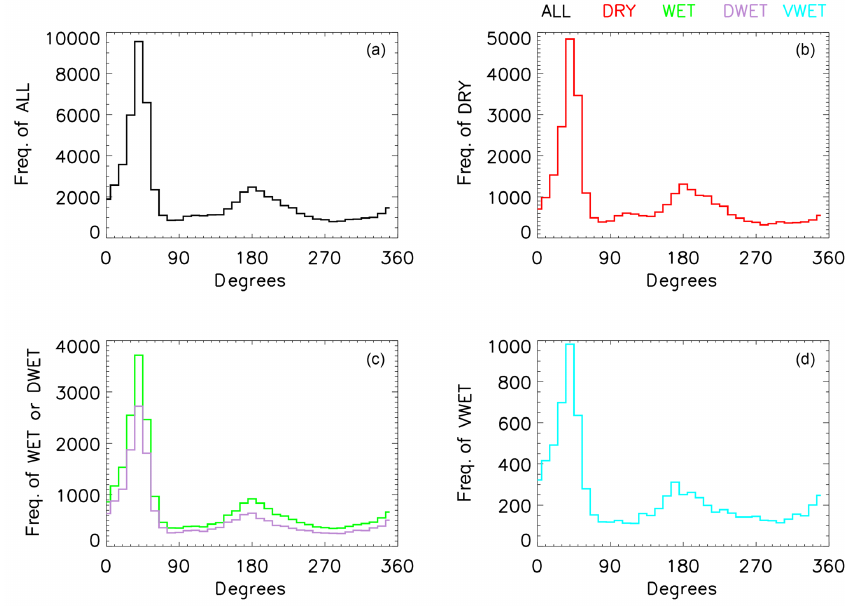
Figure 7. Histograms of half-hourly mean wind direction for 2013–2016. The colours are the same as in Figs. 5 and